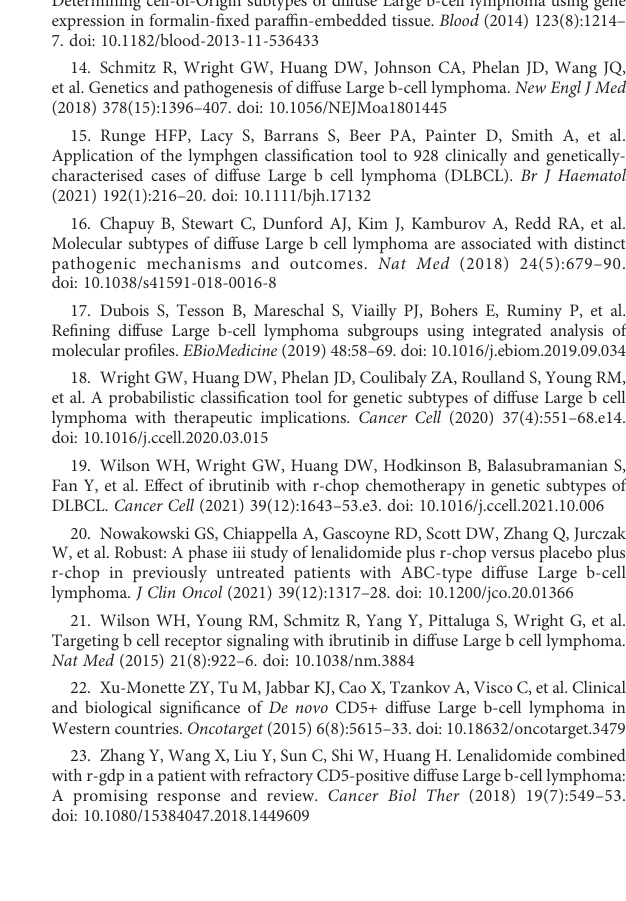
SUPPLEMENTARY FIGURE 5 (A – I) Distinct prognoses between cases with high or low mRNA expression of nine genes that correlated with PFS. Cases were divided according to whether each gene had a high or low expression by the median mRNA levels, and Kaplan-Meier plots are presented for CD5- or CD5+ cases